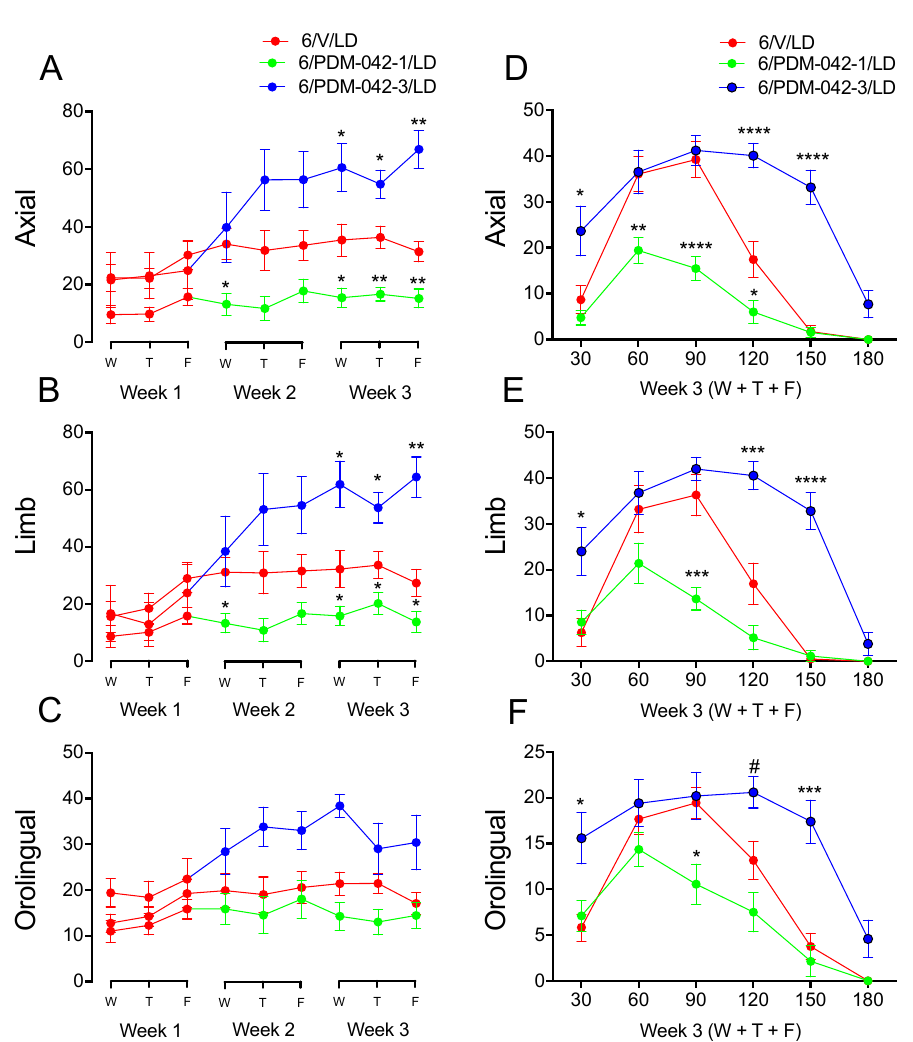
Figure 6. The effects of chronic administration of the PDE10A inhibitor PDM-042 on L-DOPA-induced AIMs are dose-dependent. The analysis of total axial ( A ), limb ( B ), and orolingual ( C ) AIMs revealed that the lower dose of PDM-042 (1 mg/kg) attenuated, whereas the higher dose (3 mg/kg) increased the incidence of AIMs (* p < 0.05, ** p < 0.01 vs. V/LD group, two-way RM-ANOVA and Holm-Sidak post-hoc test). The temporal analysis for the incidence of axial ( D ), limb ( E ), and orolingual ( F ) AIMs was investigated during the third week of chronic treatment. Scores applied at 180 min were excluded from the statistical analysis because most animals did not display AIMs at this time. However, this data point is still indicated in the chart. The analysis revealed that the lower dose of PDM-042 (1 mg/kg) attenuated AIMs during the peak effect of L-DOPA (60 to 120 min). The higher dose of PDM-042 (3 mg/kg) did not interfere with AIMs scored from 60 to 120 min but prolonged the peak-effect of L-DOPA further to 120 and 150 min ( # p = 0.09, * p < 0.05, ** p < 0.01, *** p < 0.001, **** p < 0.001 vs. V/LD group, two-way RM-ANOVA and Holm-Sidak post-hoc test). Data expressed as mean ± SEM. Results are derived from n = 9 animals in the 6/V/LD group, n = 7 animals in the 6/PDM-042-1/LD group, and 5 animals in the 6/PDM-042-3/LD